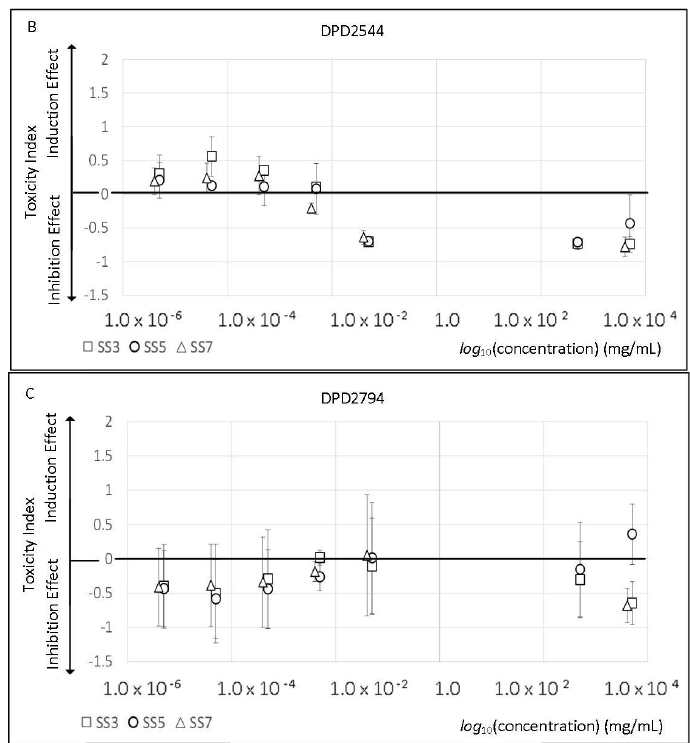
Figure 2. Sport supplements’ toxicity. Toxicity index of different sport supplements on the three tested bioluminescent bacteria strains: ( A ) TV1061; ( B ) DPD2544; ( C ) DPD2794.